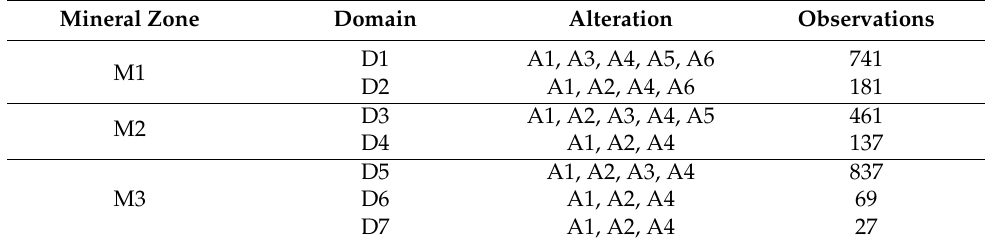
Table 5. Domains and relationship with categorical